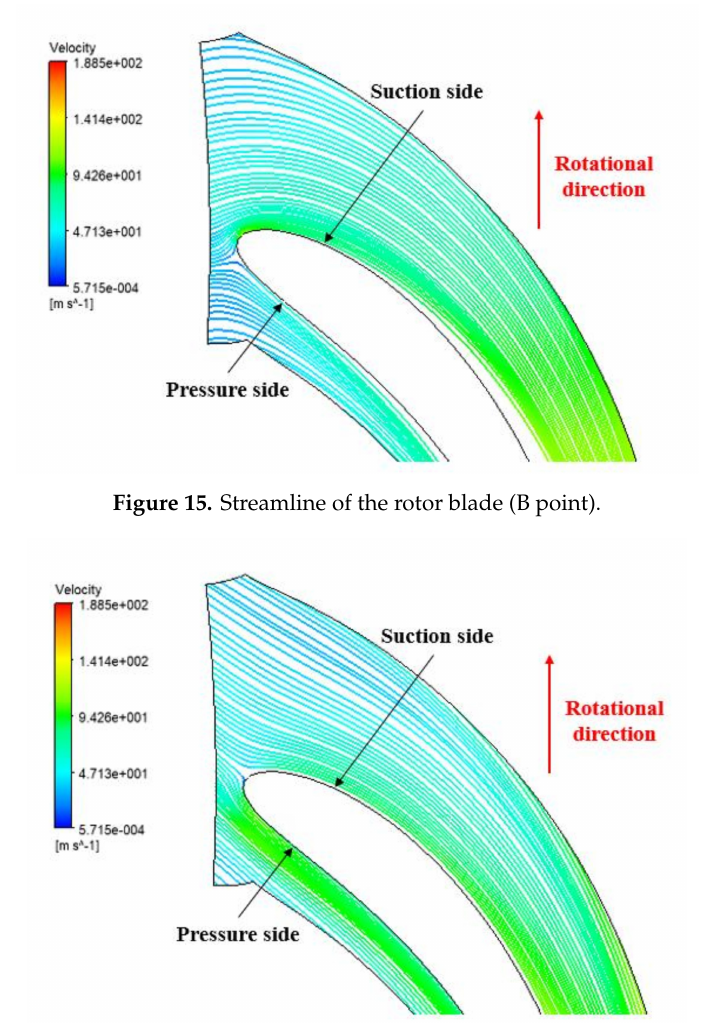
Figure 16. Streamline of the rotor blade (C point).